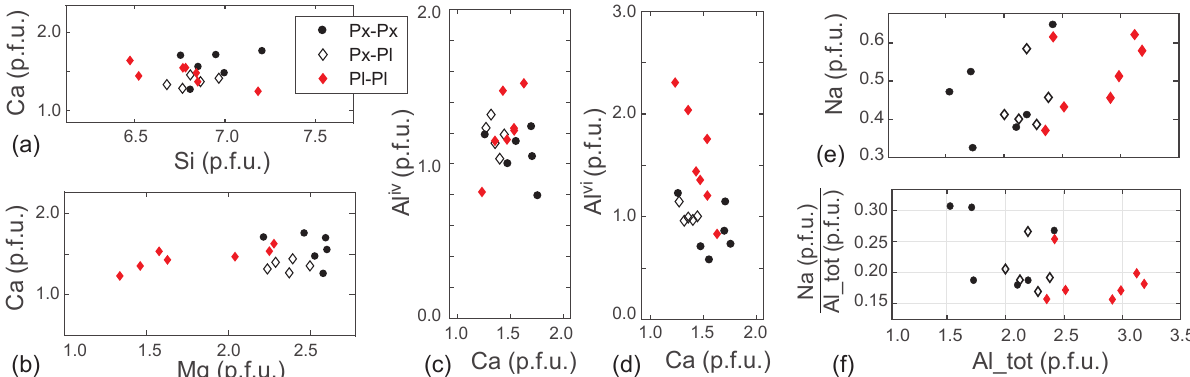
Figure 8. Amphibole chemistry. Amphibole grains of Maryland diabase experiments performed at Pc ≈ 1 . 0GPa. Measurements are grouped according to their neighborhood: Px-Px: pyroxene-dominated neighborhood. Px-Pl: amphibole grown between pyroxene and plagioclase grains; Pl-Pl: plagioclase-dominated neighborhood. (a) Ca vs. Si per formula unit (pfu). (b) Ca vs. Mg. (c) Estimated Al iv vs. Ca. (d) Esti- mated Al vi vs. Ca. (e) Na vs. Al (total). (f) Na per Al (total) ratio vs. Al